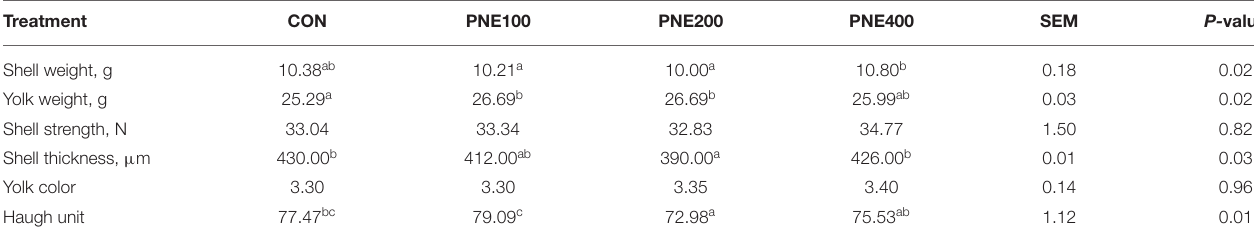
TABLE 3 | Effect of dietary PNE supplementation on egg quality parameters of laying hens 1 . Treatment CON PNE100